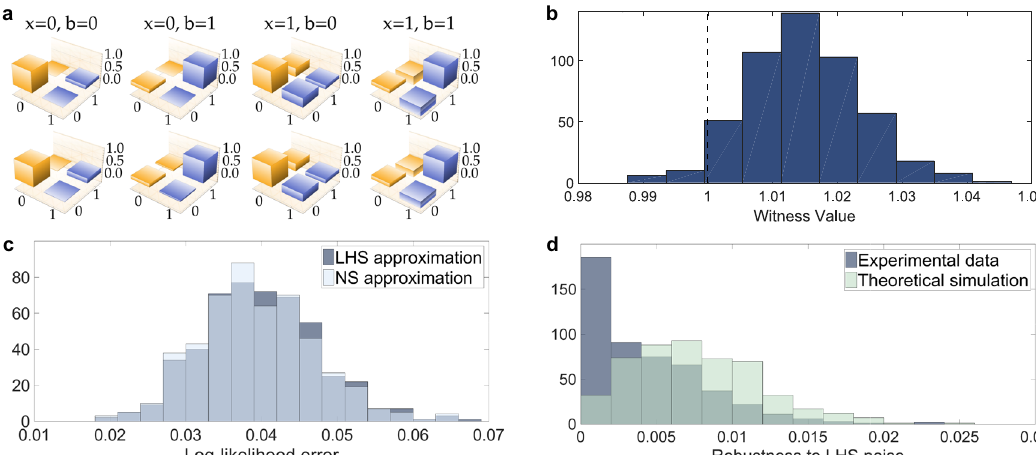
Fig. 5 Experimental results. Experimental assemblages after y = a wiring. a Real part of Charlie ’ s conditional density matrices, theoretical (top) and experimental (bottom). b Steering-witness histogram. The witness value is 1.015 ± 0.009, meaning that the experimental assemblage is more than one standard deviation above the steering threshold (dashed line). Compatibility of the tripartite experimental assemblage with the naive (LHS) de fi nition of unsteerability [Eq. (4)]. c Histogram of the error of approximating the tripartite assemblage by an NS and an LHS assemblage, showing that the error of assuming the LHS decomposition is as small as that of the physically necessary NS assumption. d From the best NS approximation to the experimental data, histogram of the LHS-robustness, a measure of deviations from the set LHS. Even with all experimental error, there is only a residual amount of robustness, fully compatible with that of the theoretical LHS assemblage solely under fi nite-statistics error. All histograms come from Monte Carlo simulation assuming Poisson